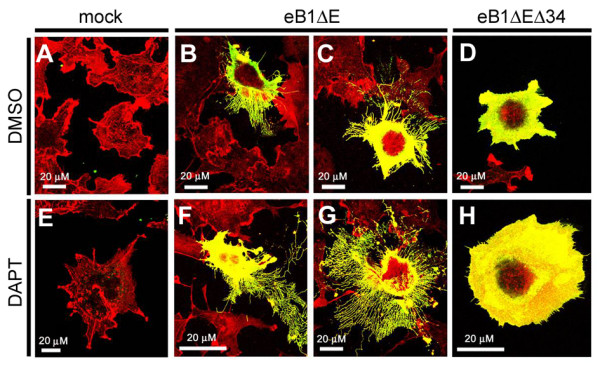
Immunocytochemical analysis of COS cells expressing eB1ΔE and eB1ΔEΔ34. COS cells were transfected with mock (A, E), eB1ΔE (B, C, F, G) or eB1ΔEΔ34 (D, H) and treated with DMSO (A-D) or DAPT (E-H). Fixed cells were probed with anti-myc (Green) and Rhodamin-Phalloidin (Red) for eB1ΔE and F-actin, respectively.